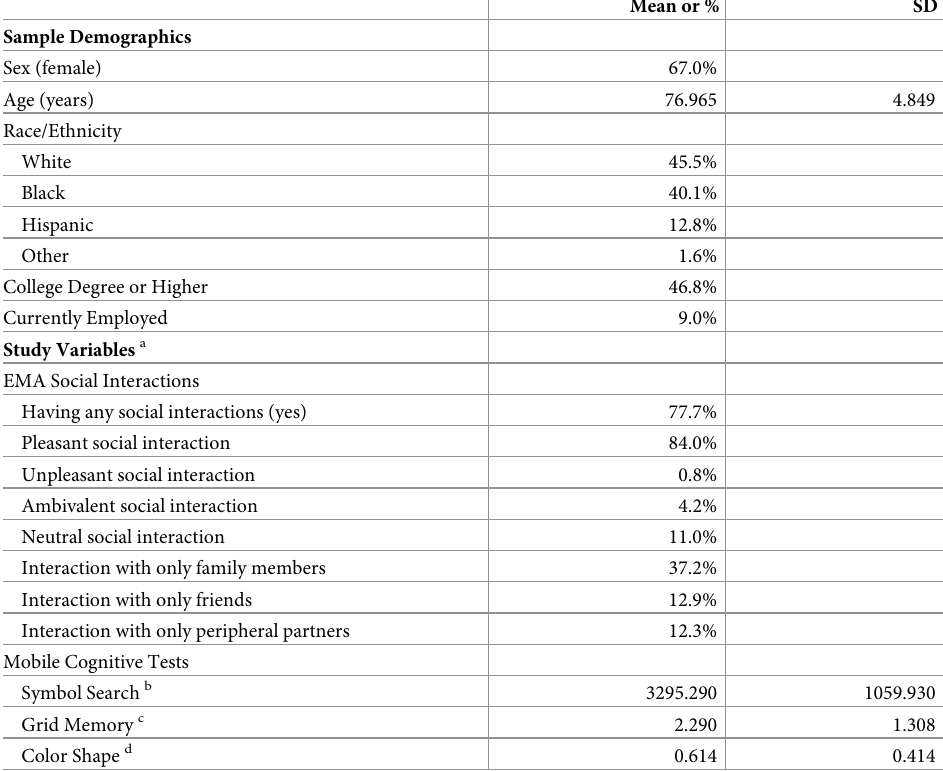
Table 1. Descriptive information on sample demographics and key study